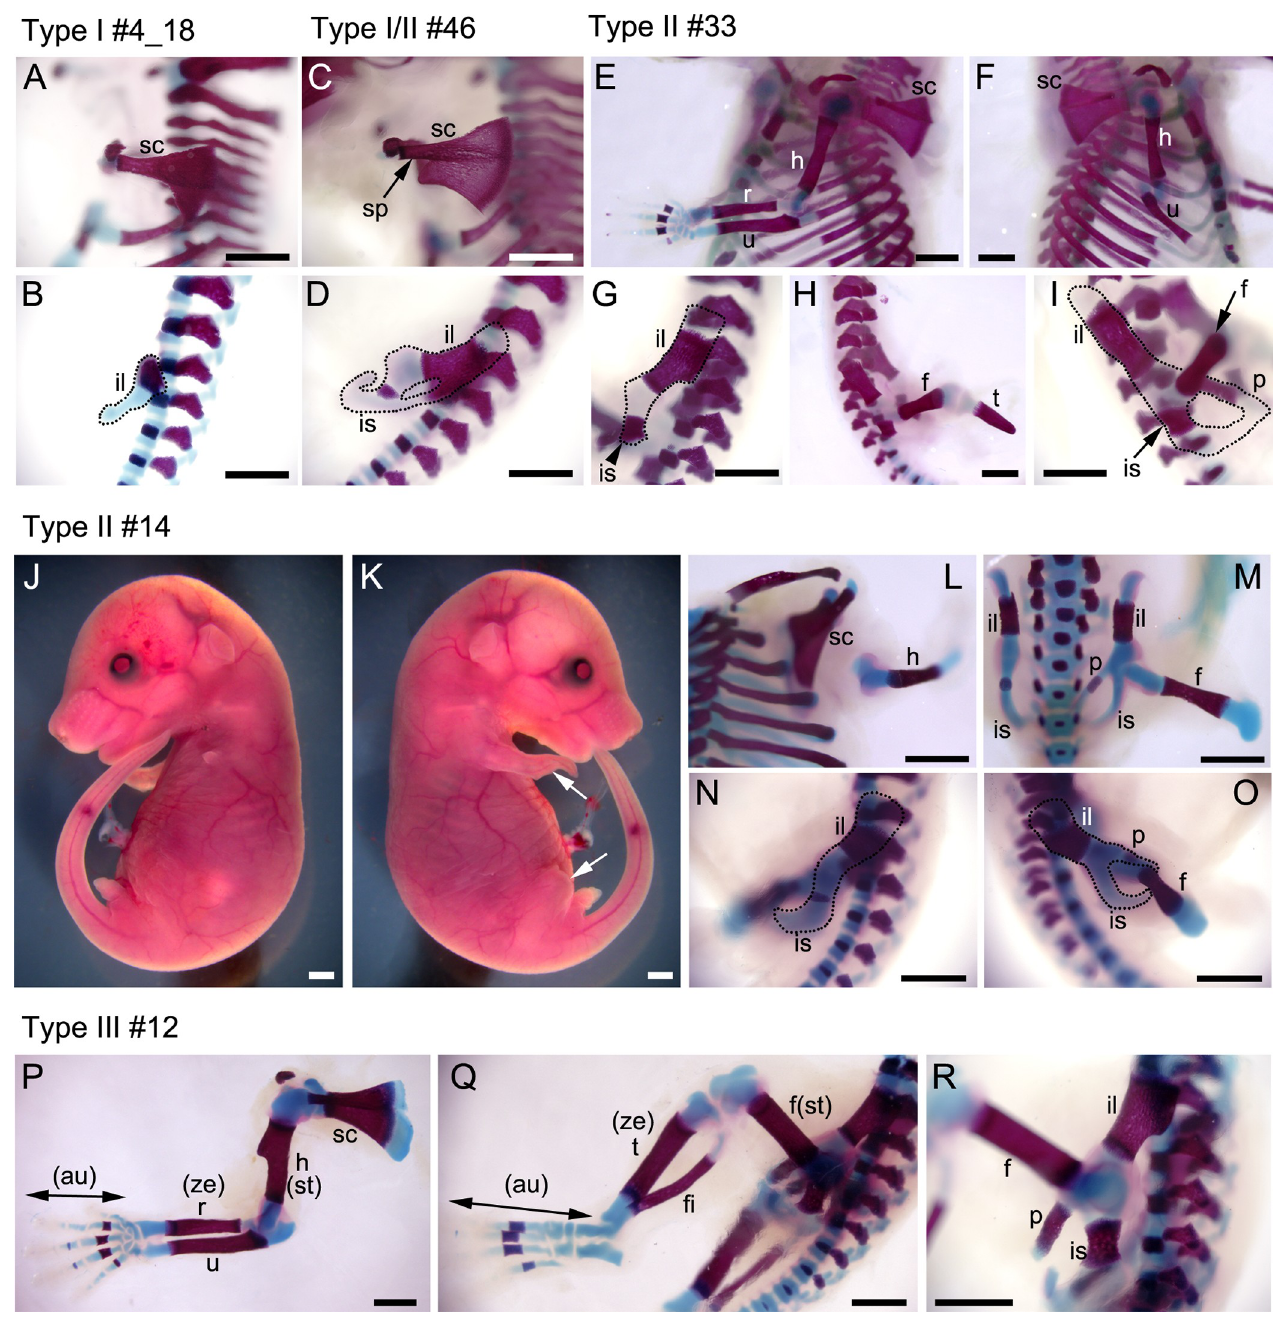
Fig 1. Cartilage and bone staining to reveal limb skeletal structures. A-I, L-R , left or right lateral views of limb and girdle regions (at E18.5) are shown. Cartilage is stained with Alcian blue and bone is stained with Alizarin red. A, B , type I #4_18 embryo. C, D , type I/II #46 embryo. E-I , type II #33 embryo. L-O , type II #14 embryo. P-R , type III #12 embryo. J, K , Lateral views of type II #14 embryo are shown. Arrows in ( K ) show truncated limbs. au, autopod; f, femur; fi, fibula; h, humerus; il, ilium; is, ischium; p, pubis; r, radius; sc, scapula; sp, spine; st, stylopod t, tibia; u, ulna; ze, zeugopod. Scale bars: 1 mm. https://doi.org/10.1371/journal.pone.0240333.g001 E16.5 embryos. We estimated mutation frequencies based on band intensities [23], and found an embryo (type II, #4) with obvious limb defects but showed faint band intensities for mutated DNA after endonuclease treatment (S3B Fig). Sanger sequencing indicated a mixed genotype of wild type and a single nucleotide insertion in this embryo (S3C Fig).